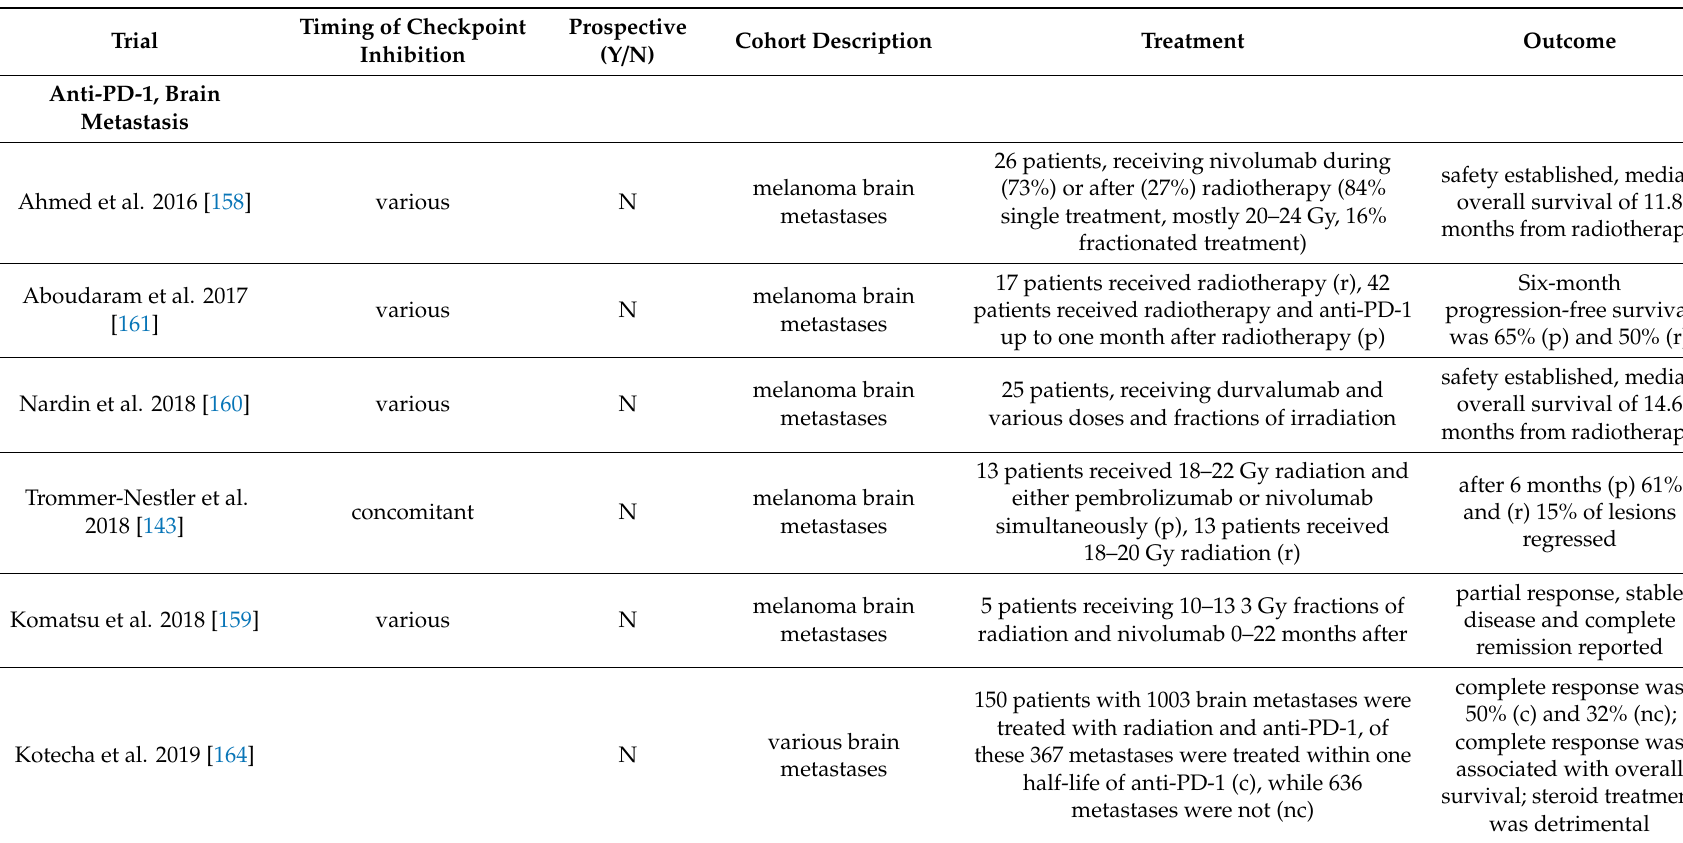
Table 3. Overview of clinical trials concerning combination of radiotherapy and anti-PD-1 treatment in various cranial metastatic settings. Clinical trials are sorted primarily by cancer and treatment setting, secondary criteria being chronological. Short descriptions of patient collective, treatment, and outcome are